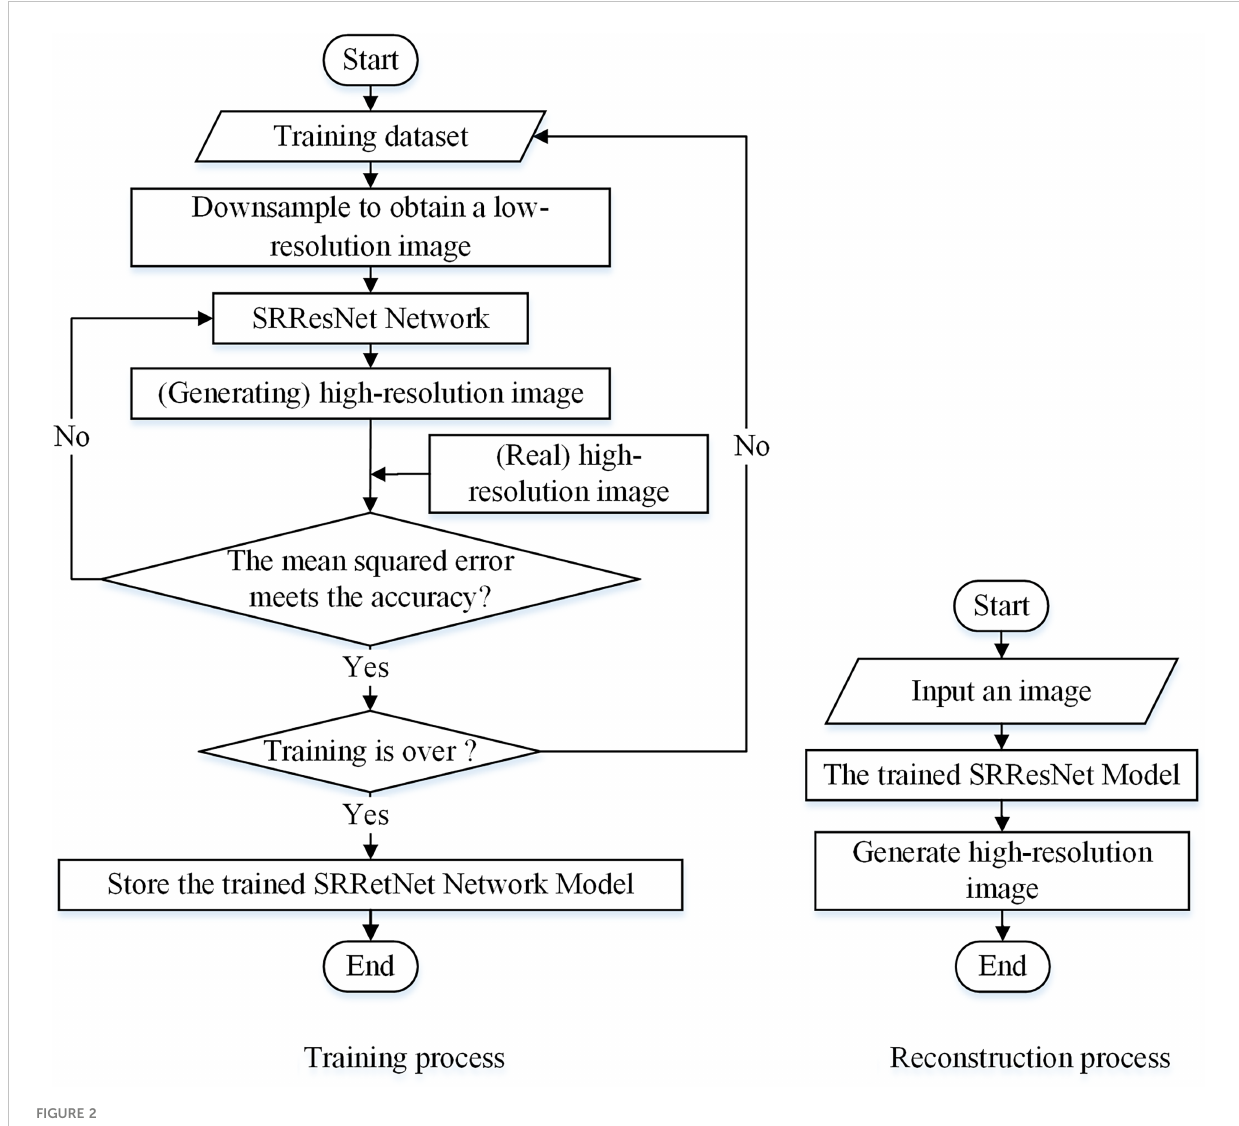
FIGURE 2 Image super-resolution reconstruction process for